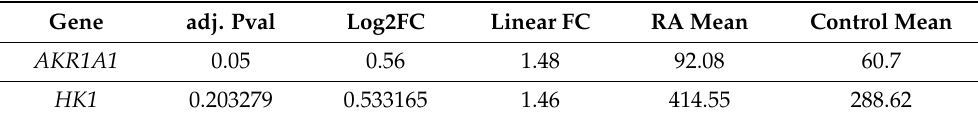
Table 20. Expression levels of AKR1A1 and HK1 in untreated RA CD8 + Temra cells. Means are calculated from DESeq2 normalized